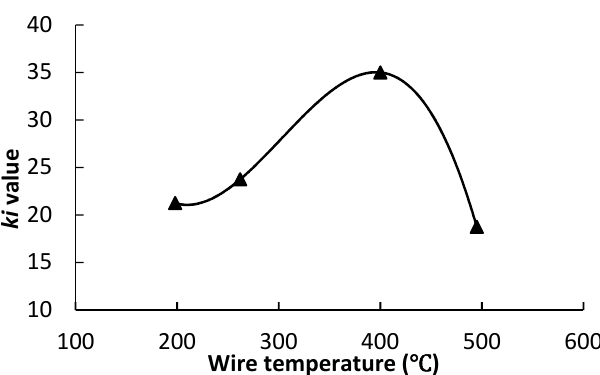
Figure 7. Relationship between wire temperature and weld formation ki value.